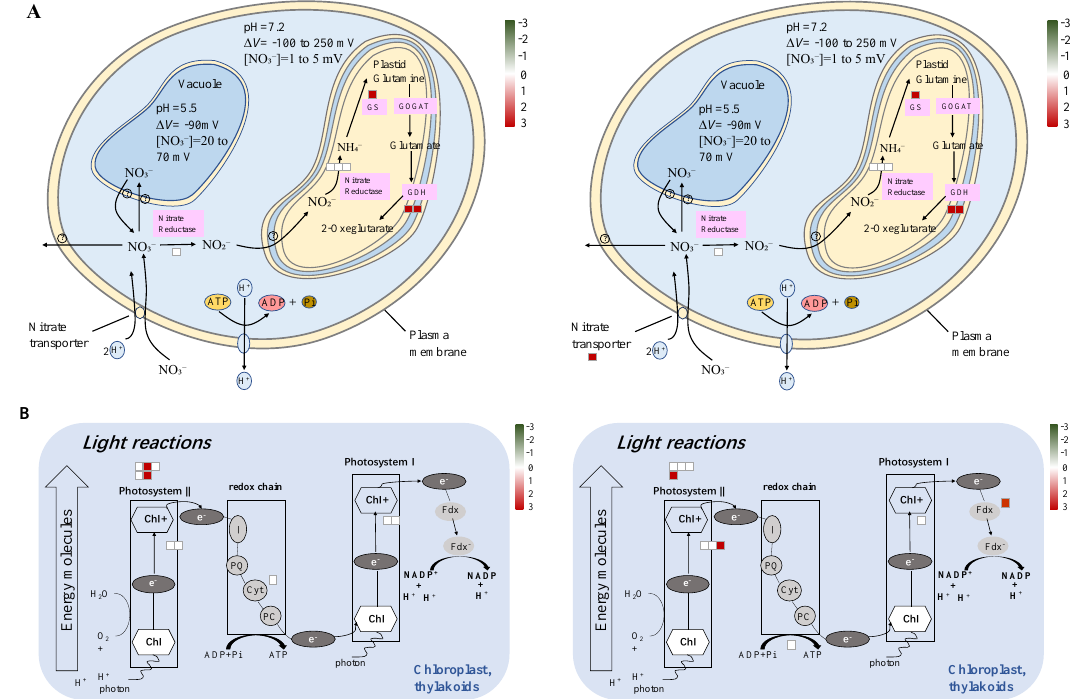
Figure 10. Overviews of NO 3 − metabolism ( A ) and light reactions ( B ) of the DAPs. Both in the NO 3 −